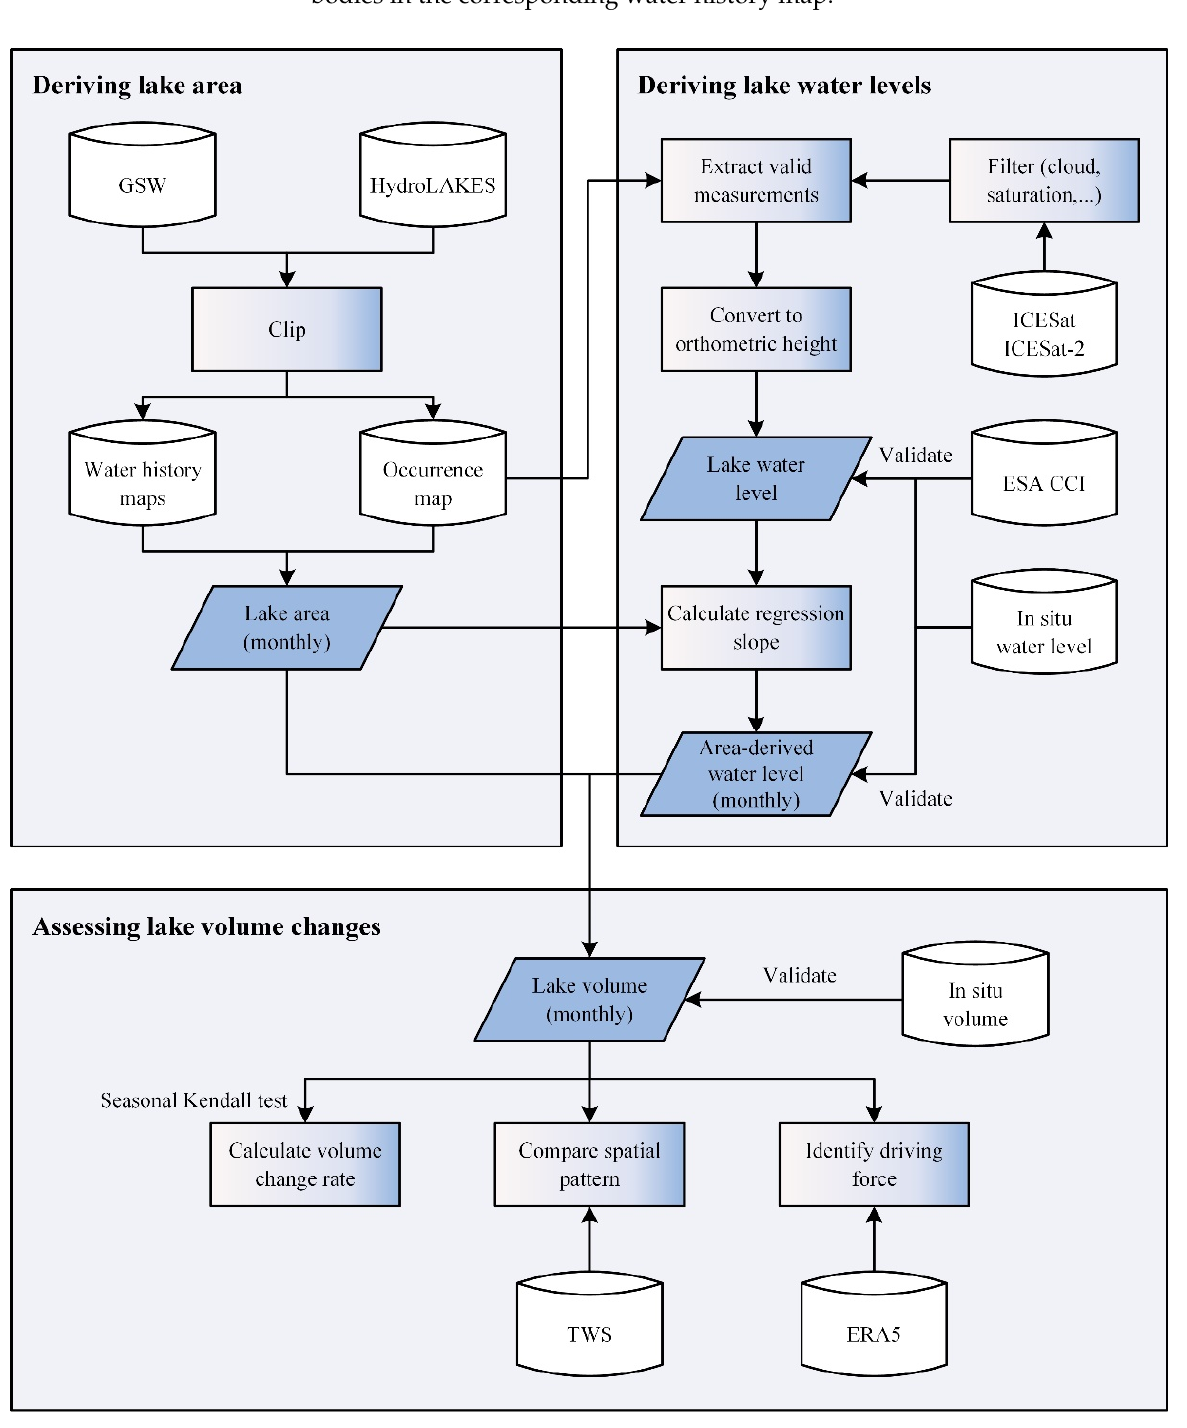
Figure 1. Methodological framework of this study. Abbreviations: Global Surface Water (GSW), Ice Cloud and land Elevation Satellite (ICESat), European Space Agency Climate Change Initiative (ESA CCI); total water storage (TWS), and ERA5 (European Centre for Medium-Range Weather Forecasts Reanalysis v5). For more details on the methods, see Figures S1 and S2.